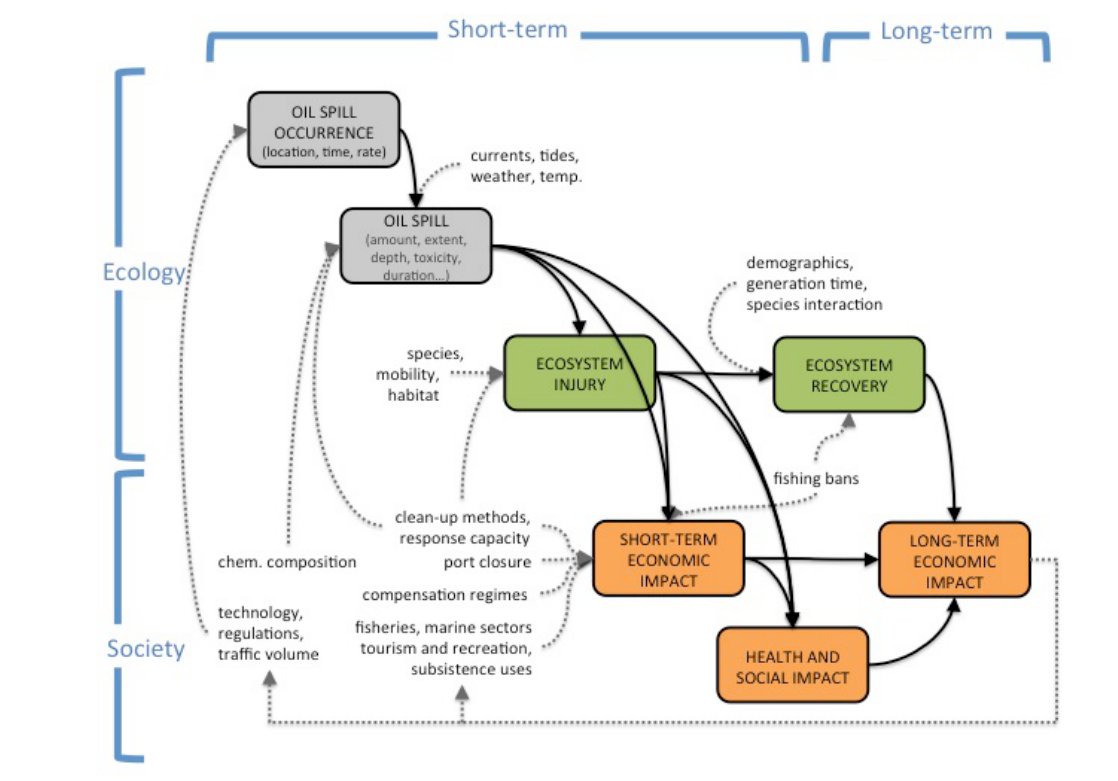
Fig. 1 . Oil spill impacts framework. (BOXES = outcomes, lowercasen = variables, solid lines = linkages between oil spill occurrence and socioeconomic impacts, dotted lines= linkages between exogenous variables and outcomes. Grey boxes indicate oil spill outcomes; green boxes, ecosystem consequences; and orange boxes, societal